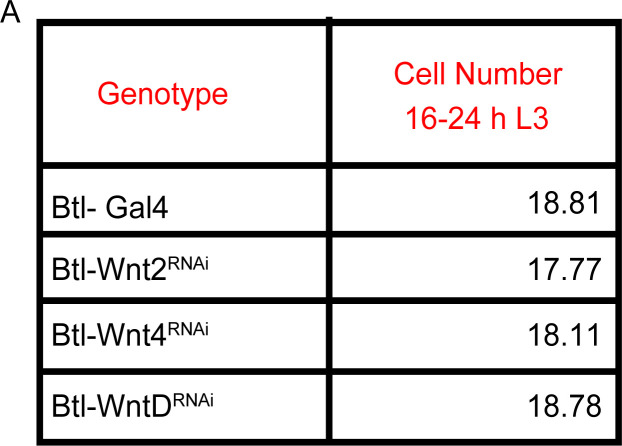
Loss of Wnt2, Wnt4 or WntD does not lead to precocious proliferation in Tr2 DT.(A) Impact of reduction of Wnt2, Wnt4 and WntD on cell numbers in Tr2 DT. Table shows cells numbers in wild type (btl-GAL4), Btl-Wnt2RNAi (btl-GAL4/+; UAS-Wnt2RNAi/+), Btl-Wnt4RNAi (btl-GAL4/+; UAS-Wnt4RNAi/+) and Btl-WntDRNAi (btl-GAL4/+; UAS-WntDRNAi/+) at 16–24 h L3 (mean values ± standard deviation, n ≥ 7 tracheae).